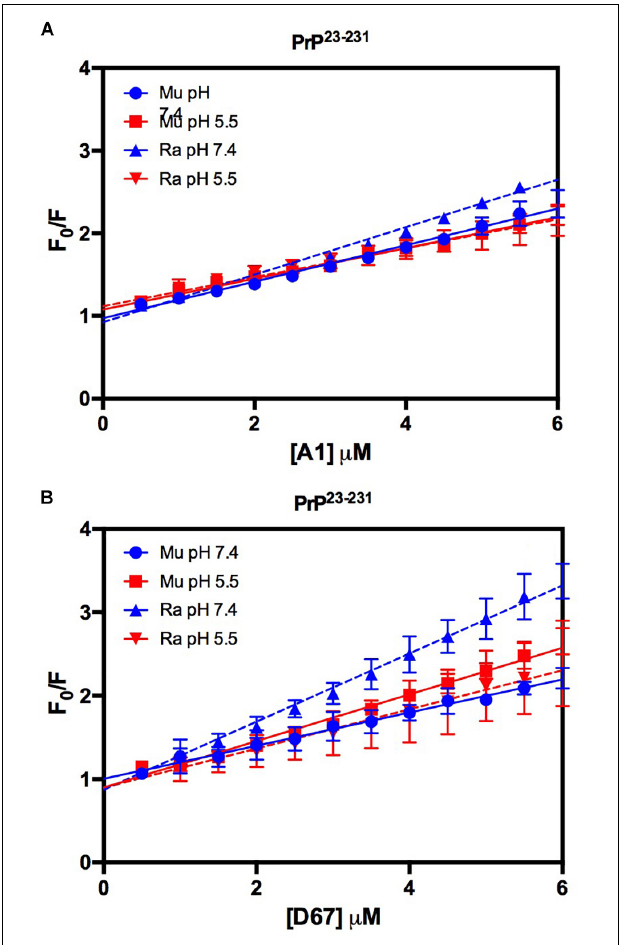
FIGURE 11 | The intrinsic fluorescence of PrP 23 − 231 is reduced upon binding to DNA oligonucleotides. F 0 /F curves for titrations of A1 (A) and D67 (B) on PrP 23 − 231 at pH 5.5 or 7.4. The curves were performed with 2 µ M PrP 23 − 231 and increasing concentrations of oligonucleotides (from 0.5 to 6 µ M). The experiments were performed in 50 mM Tris buffer containing 100 mM NaCl at pH 7.4 or 20 mM sodium acetate buffer containing 100 mM NaCl at pH 5.5. All experiments were performed at 25 ◦ C. The error bars represent the standard deviation of at least two independent